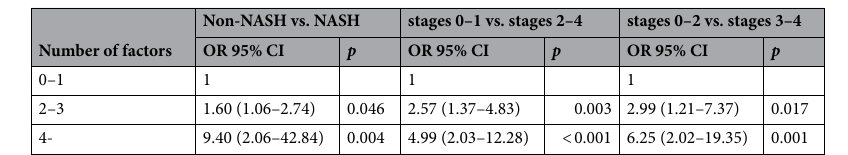
Table 5. Multivariate logistic regression analysis by the number of factors. CI confidence interval, NASH non- alcoholic steatohepatitis, OR odds ratio.